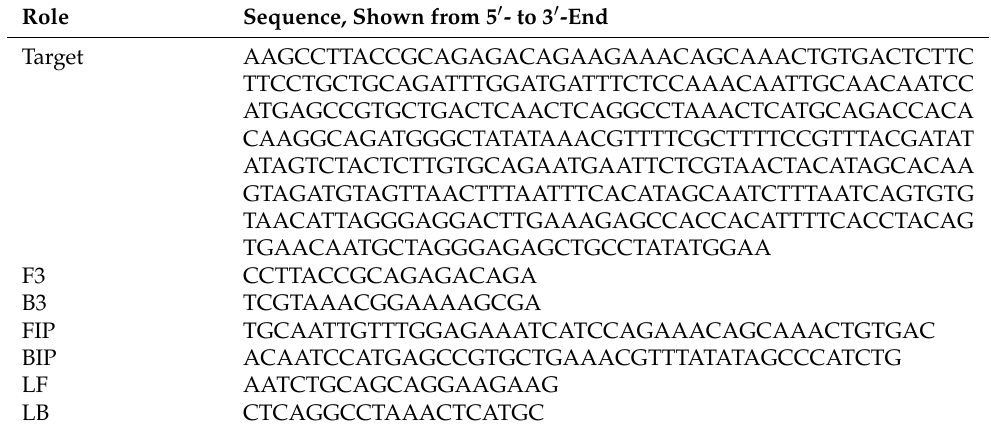
Table 1. Sequences information: a target of 360 bases was taken from the sequence of SARS-CoV-2 BA.5.1. One of the ds cDNA (red line in Figure 1b) is listed here. Six primers of F3, B3, FIP, BIP, LF, and LB were designed for LAMP reaction. F3, B3, FIP, BIP, LF, and LB have 18, 18, 43, 42, 19, and 19 bases, respectively. Conjugations to some of the primers are described in the